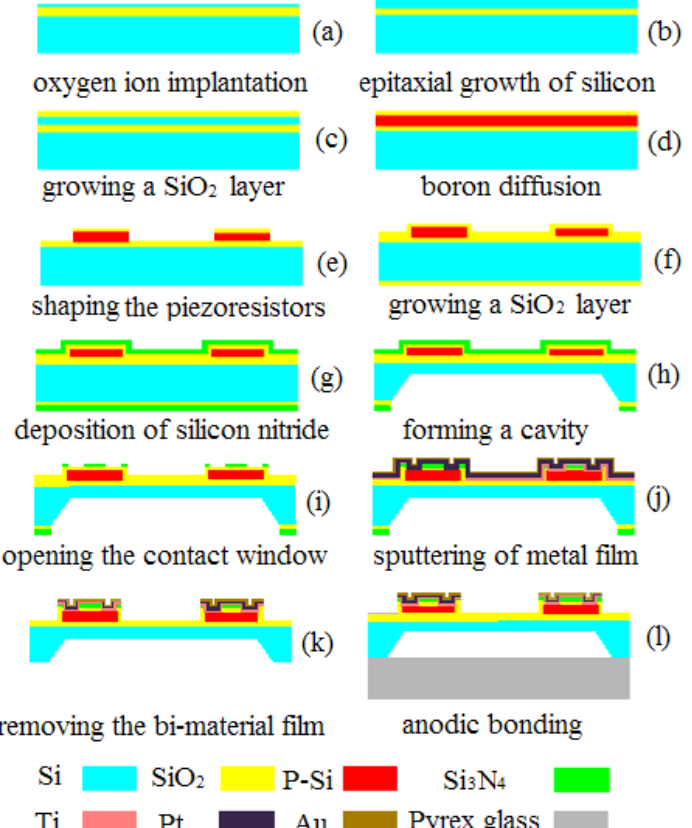
Figure 6. Fabrication process steps of the micro pressure